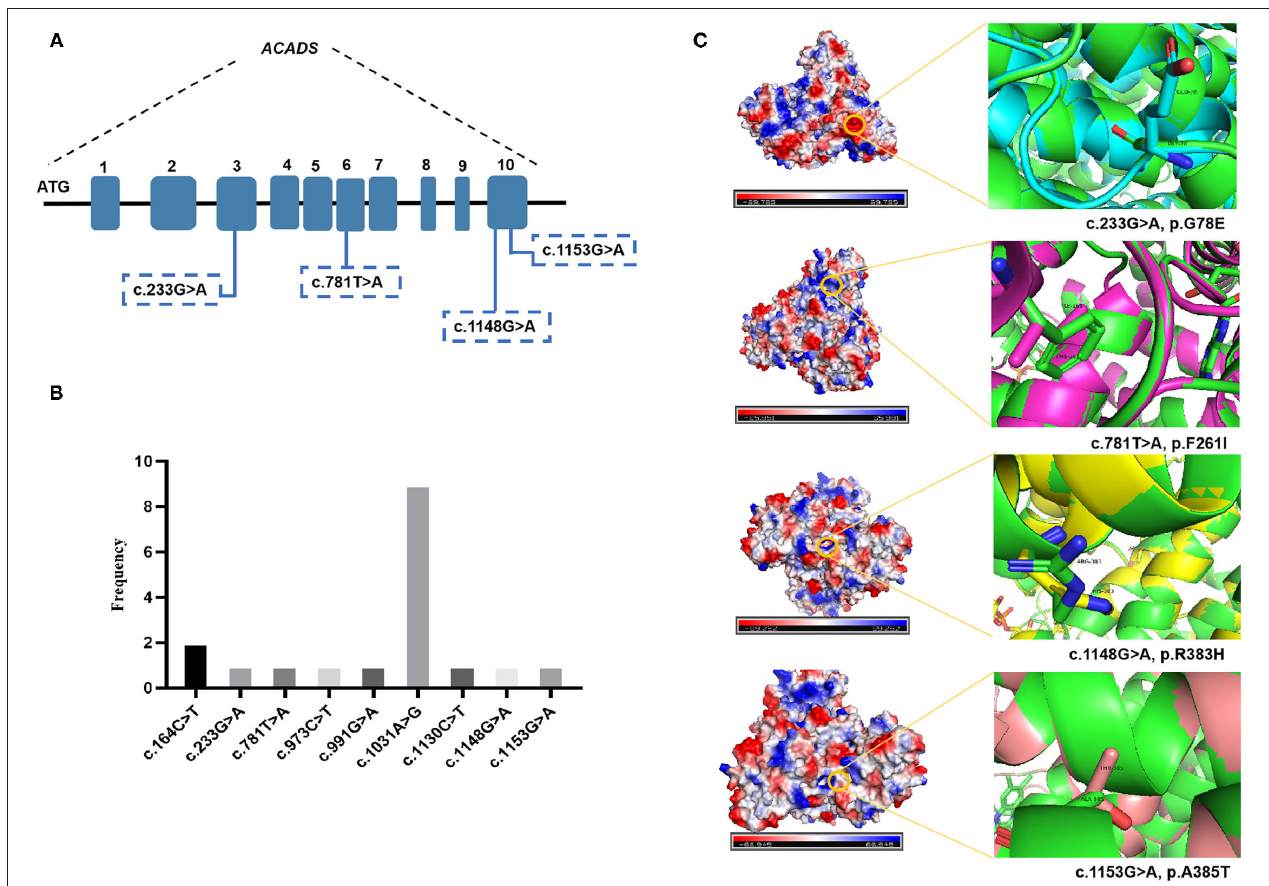
FIGURE 2 | Bioinformatic analyses of ACADS -encoded proteins: three-dimensional structural modeling of mutant SCAD proteins. The green color represents the wild-type protein. (A) Four novel ACADS gene variants. (B) Frequency of different ACADS gene variants. (C) Swiss modeling and surface charge structure of novel SCAD